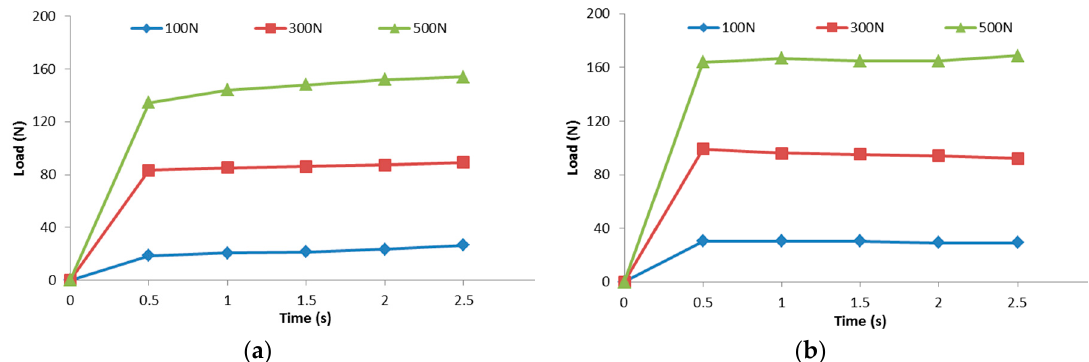
Figure 4. Friction forces between dry fabric and mold at three kinds of applied normal forces (100 N, 300 N, and 500 N): ( a ) transversely oriented UD fabric; and ( b ) PW fabric.